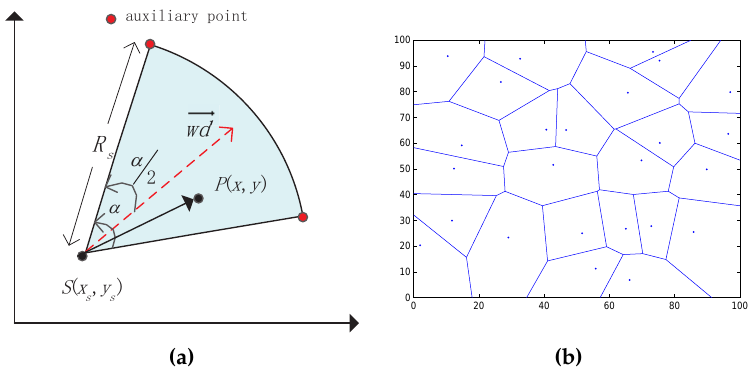
Figure 1. Sensing model of directional sensor networks (DSN) and Voronoi diagram ( a ) Sensing model; ( b ) Voronoi